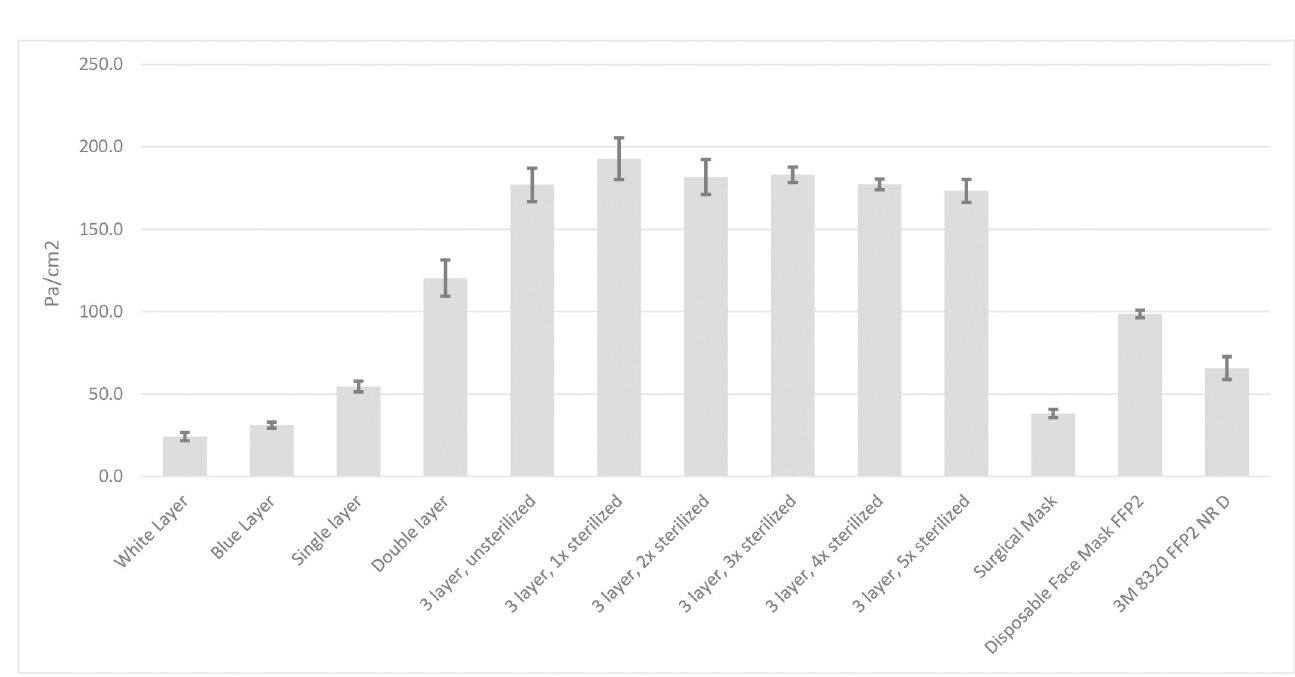
Fig 3. The differential pressure over the different layers of materials, including after different rounds of sterilization. As a comparison the differential pressure is compared to commercially available surgical masks and disposable FFP2 respirators.